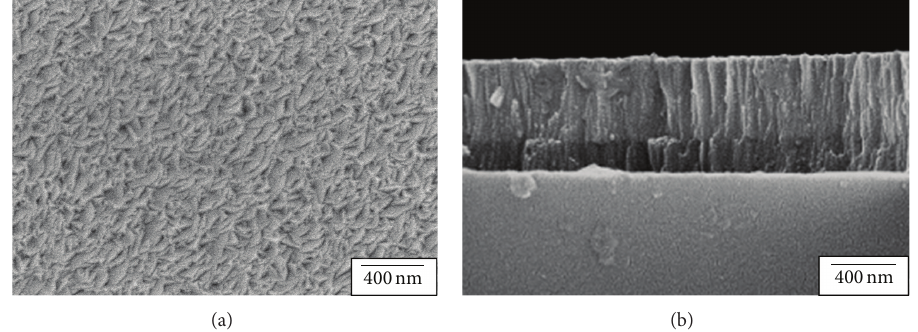
Figure 6: SEM images of (a) the top surface and (b) the fracture surface of the bilayer Mo films prepared at 30W/12 mTorr for 10 min and subsequently at 100 W/4.5 mTorr for 20